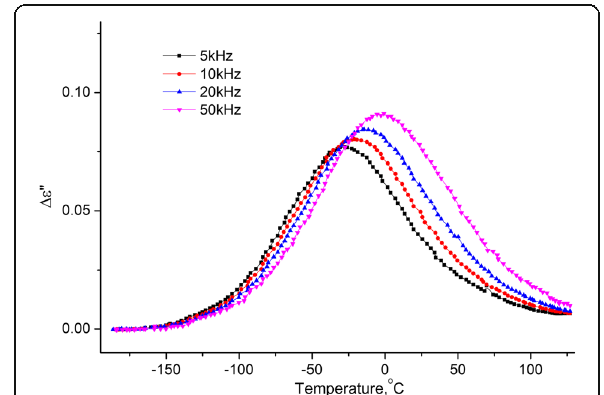
Fig. 7 Dependencies of the dimensions of crystallite of MCC B hlk on water content. Dependencies of the dimensions of crystallite of MCC B hlk on water content, a — transversal dimensions of MCC crystallite ( black ) and growth of its dimension with the humidity increase ( blue — MCC + 4% and red — MCC + 10%)